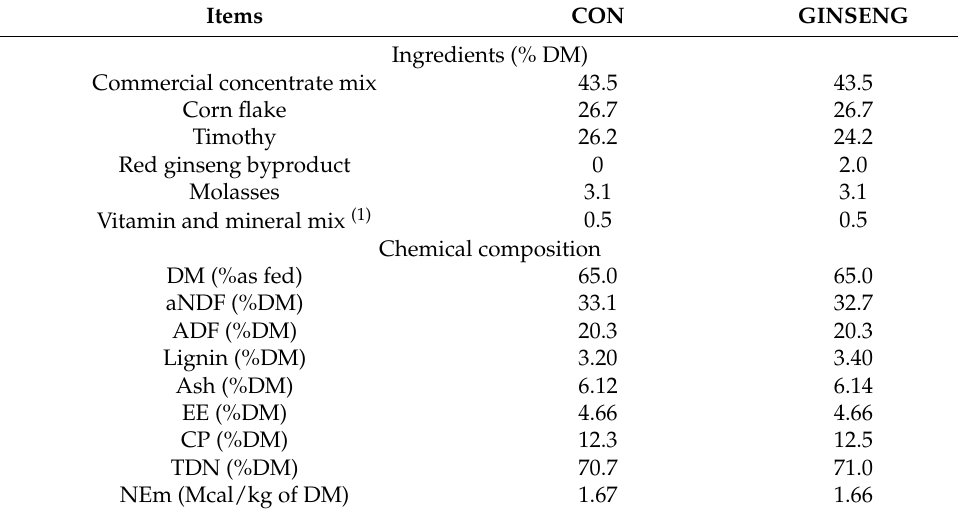
Table 2. Experimental diet formulation and chemical